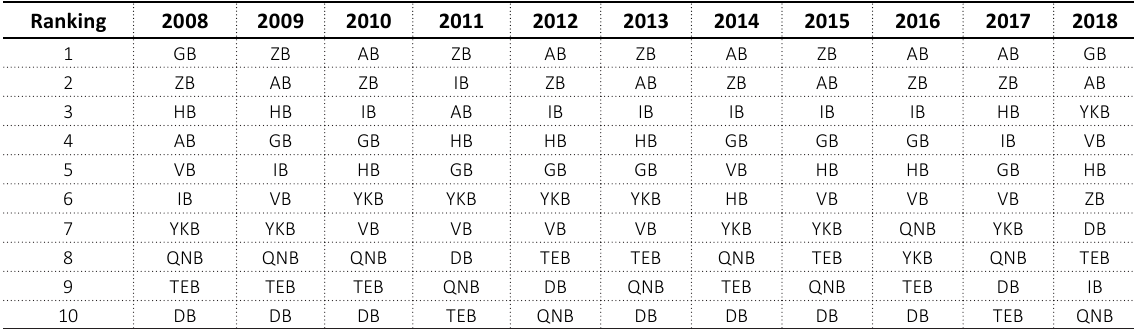
Table 10. Second stage rankings of banks